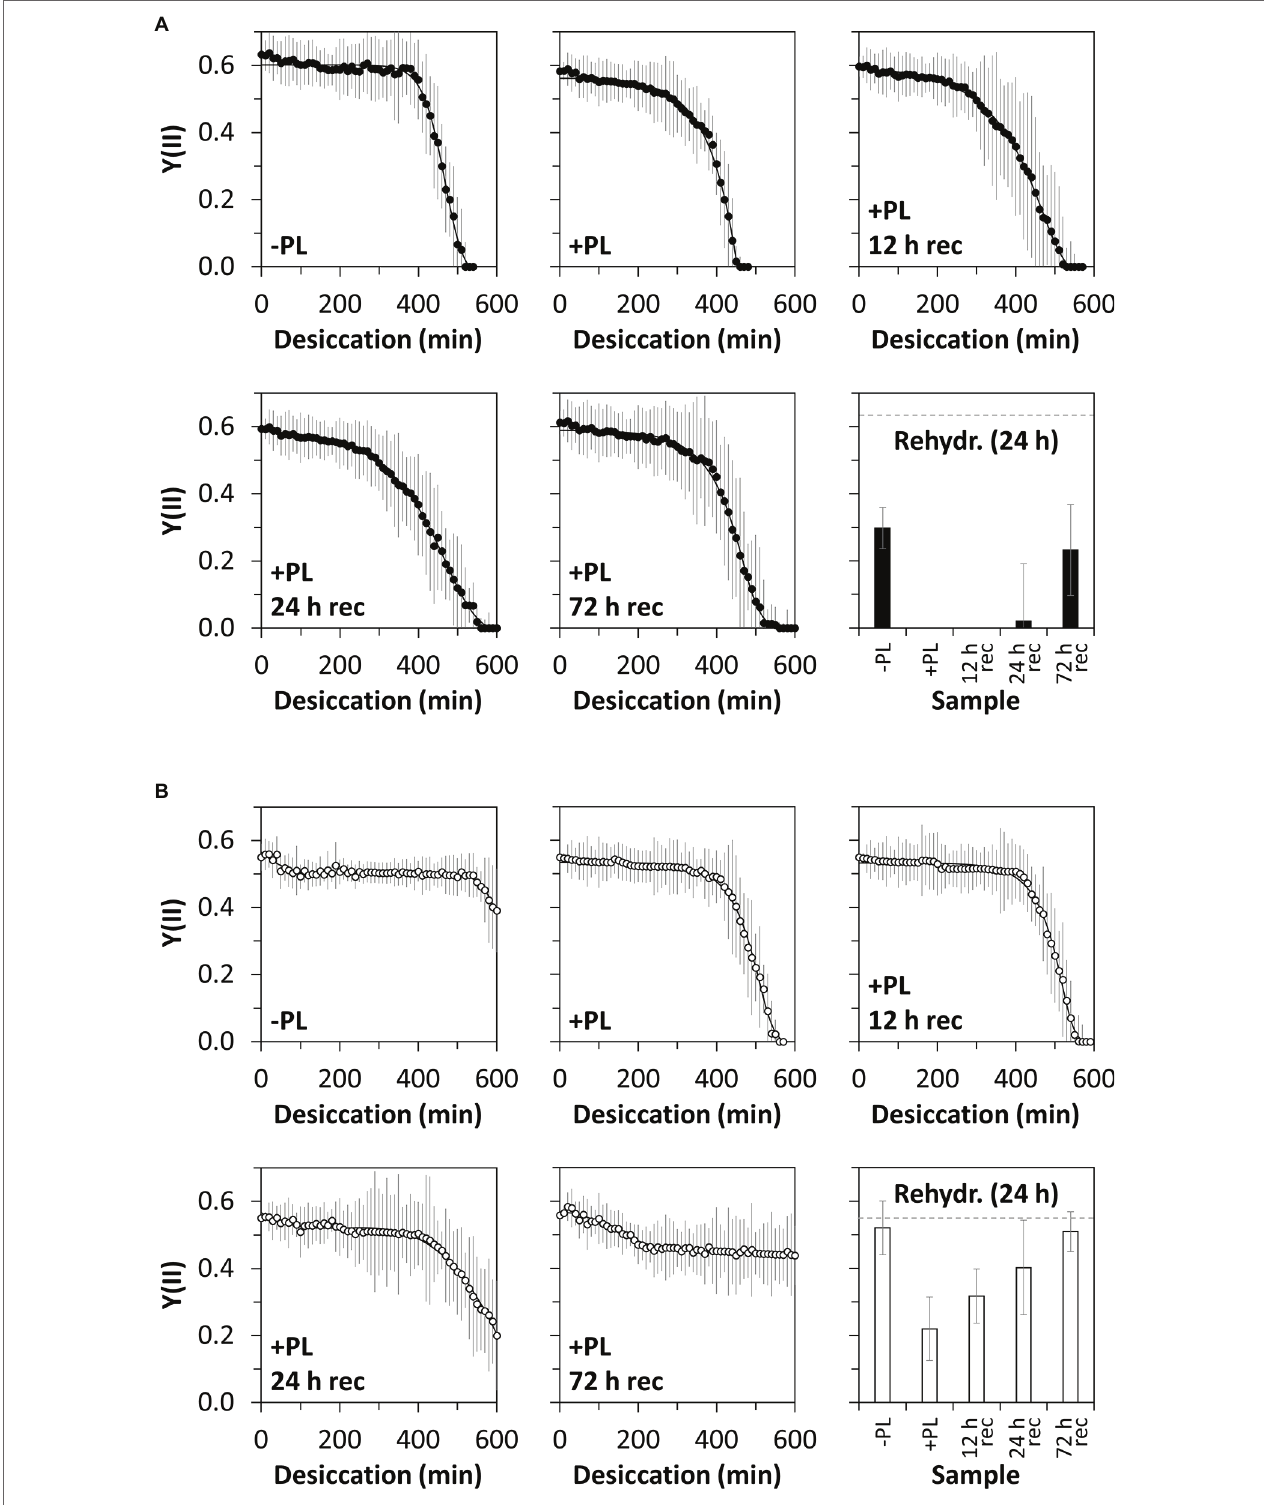
FIGURE 5 | Effective quantum yield of PSII [Y(II)] in response to desiccation and pectate lyase (PL) treatment. Young (A) or old (B) algal filaments were desiccated at ~84% RH for up to 10 h after no PL treatment (−PL), after PL treatment (+PL) or after PL treatment followed by 12, 24, or 72 h recovery (+PL, 12 h rec–72 h rec). After recording desiccation kinetics, all samples were rehydrated for 24 h and their Y(II) measured. The dashed grey lines on the rehydration charts indicate the initial Y(II) of −PL samples. n = 6 ±